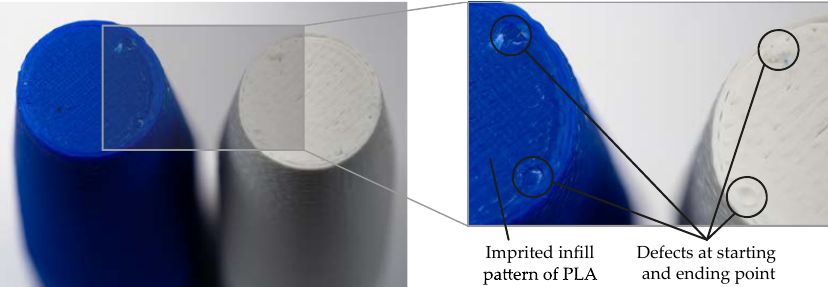
Figure 7. Failure pattern of multi-material tensile specimen 4 made of PLA (white) and ABS (blue) with illustration of the imprinted infill pattern of the PLA part on the ABS surface and the defects on starting and ending points.